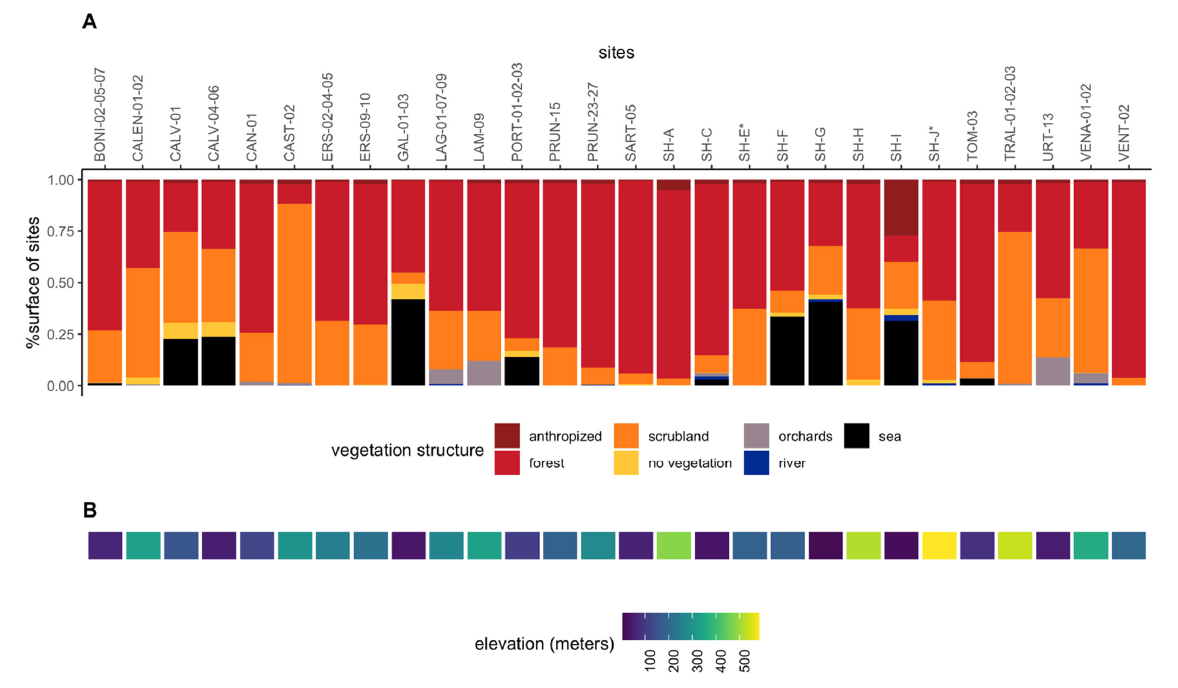
Figure 2. Vegetation structure and elevation of the sampling sites . ( A ) Proportion of each vegetation structure in all sites sampled ( B ) Elevation of the sample sites (in the same order as in A). The vegetation structure is given within a radius of 1 km around the sampling sites. See also the additional map.